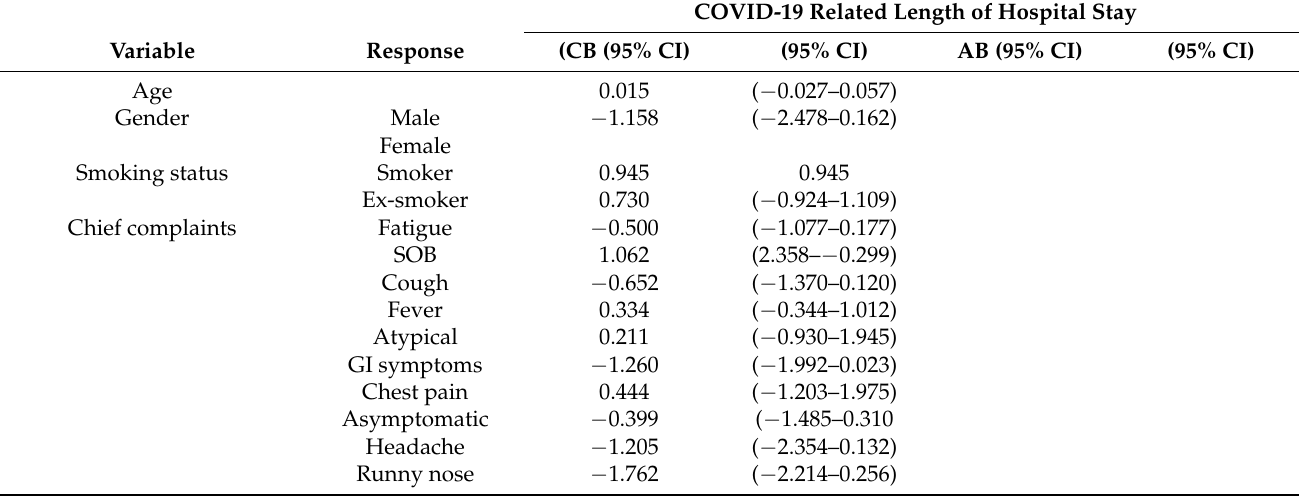
Table 7. Regression Analysis of Predictors of the Length of Hospital Stay ( n =